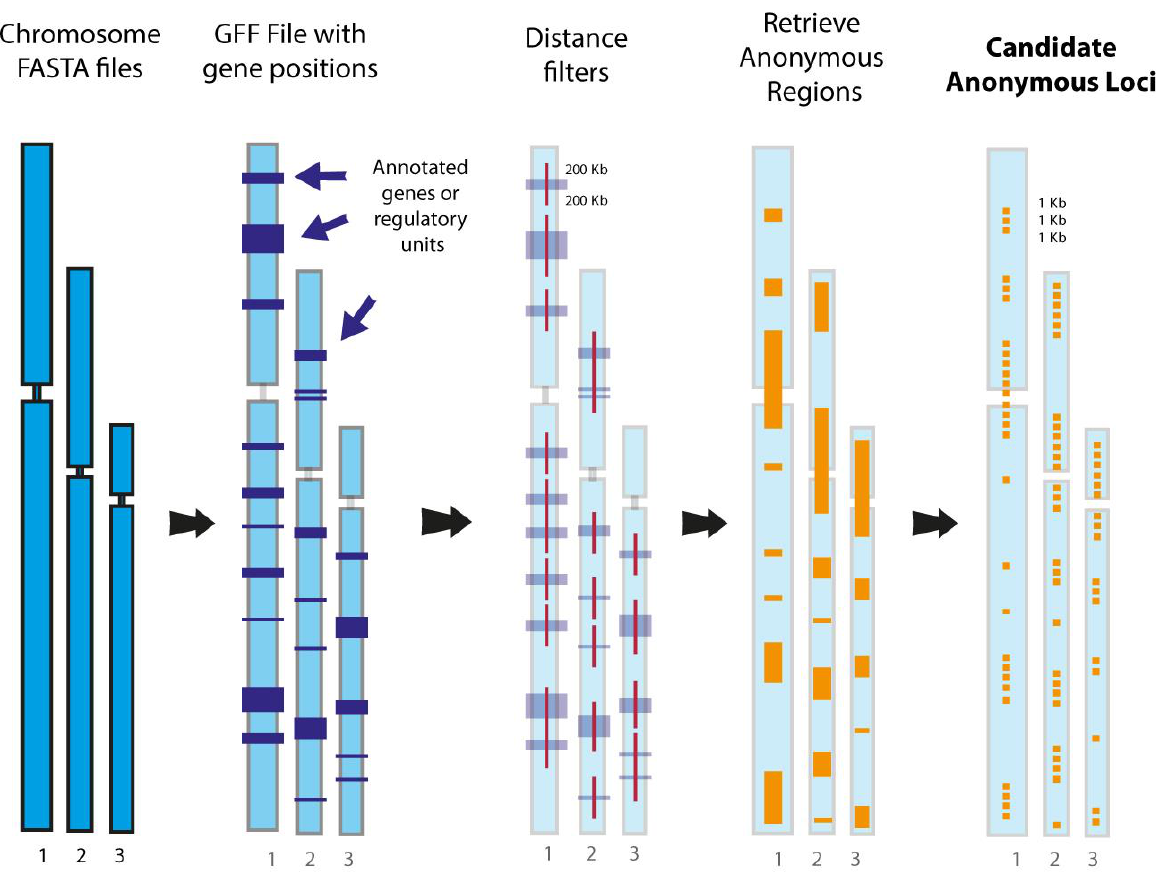
Figure 5. The ALFIE software pipeline for in silico extraction of anonymous loci sequences from complete genome sequences and assembling ready-to-analyze data sets. The user first inputs genome sequences in FASTA format, one of which must be a reference genome with a GFF (general features format) file of genomic annotations, namely protein-coding genes, and regulatory regions. The program then maps the presumably neutral intergenic or “anonymous” regions by applying a user-specified physical distance threshold (in base pairs [bp]). This filter discards all chromosomal regions that contain known functional elements and their flanking sequences (up to the threshold distance), thereby helping to ensure that retained anonymous regions are unaffected by natural selection (e.g., background selection). The anonymous regions are then split into user-specific locus lengths (in bp), which are referred to as “candidate anonymous loci.” In the final steps (not shown), the program uses candidate anonymous loci as query sequences to conduct BLAST searches against all input genomes, keeping only single-copy loci in all genomes, before saving them to a FASTA file. Next, the program conducts multiple sequence alignments for all loci before using a second user-defined distance threshold (in bp) to retain loci that are spaced far enough from other sampled loci that they likely meet the independent gene tree assumption. Lastly, the program outputs the dataset in NEXUS, PHYLIP, and FASTA formats, and can use other included modules to find in automated fashion the best DNA substitution model and gene tree for each locus (figure modified after Figure 1 in Costa et al. [193]). See also Jennings [189] for further explanation and extensions of physical distance threshold theory. Reprinted with permission from Costa et al.